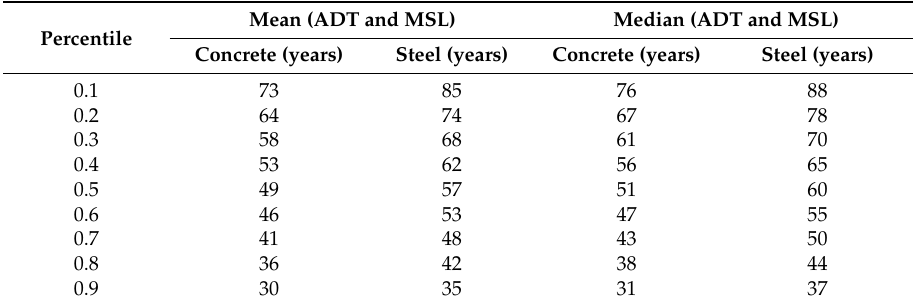
Table 6. Deciles for estimated age at the end of service Life using Hypertabastic accelerated failure time